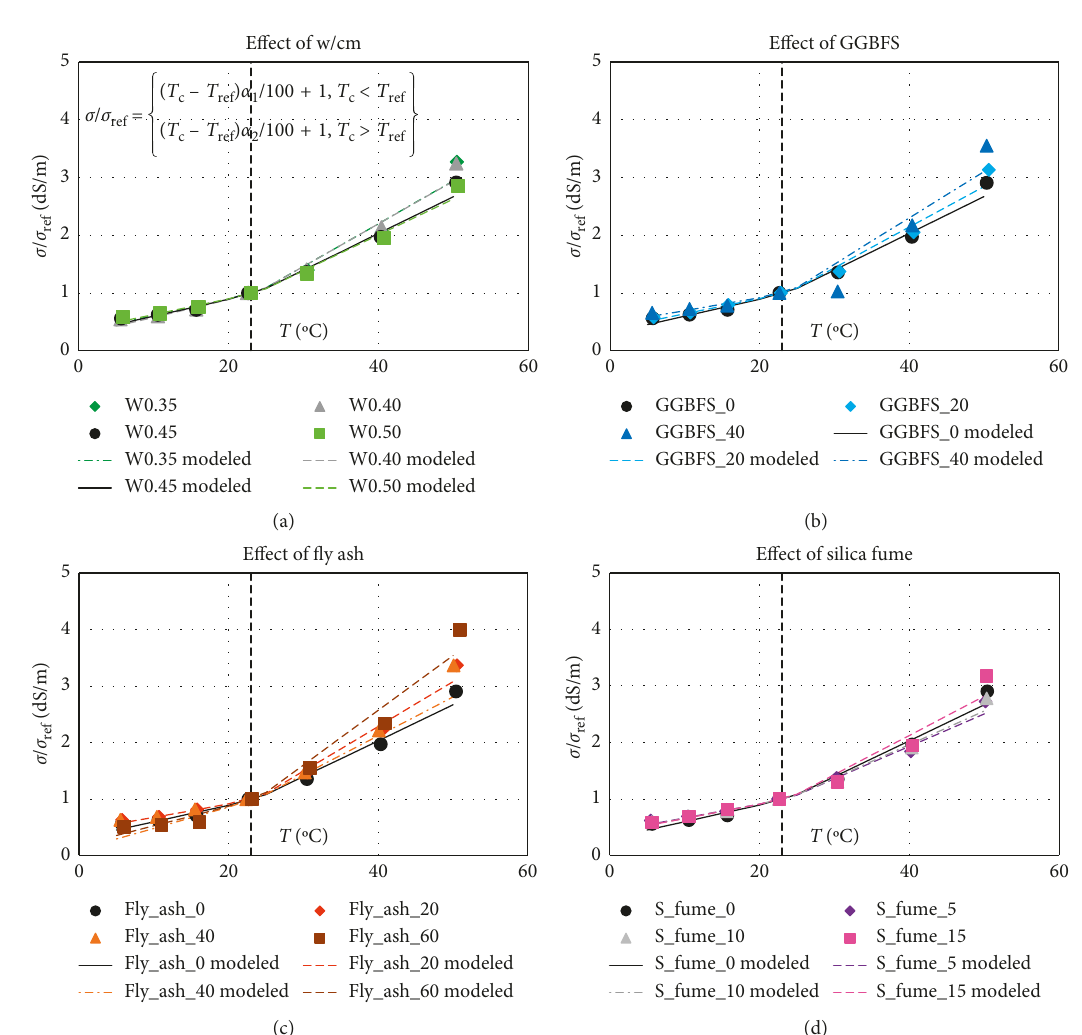
Figure 4: Experimental and modeled σ/σ ref at various T c ’s based on bilinear temperature correction (equation 3) for all mixtures. Vertical dashed line corresponds to T ref 23 ° (cid:31)